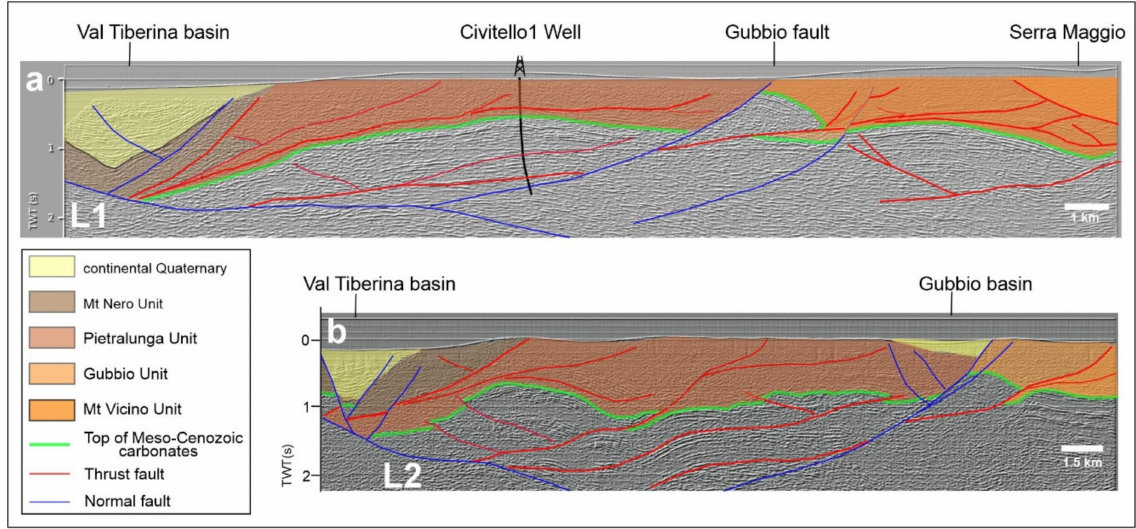
Figure 4. Interpreted seismic reflection profiles crossing the deformed Marnoso Arenacea, cropping out between the Tiber valley Quaternary graben and the Apennine calcareous chain; ( a ) = line L1, ( b ) = line L2 whose traces are shown in Figure 1. Both the “clean” sections are taken from [51] and here re-interpreted in light of the different aims of our